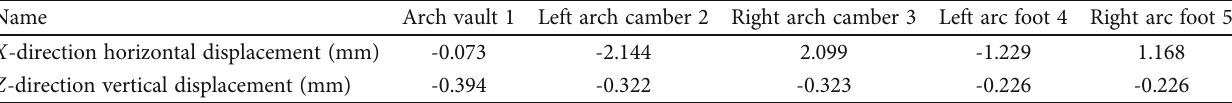
Table 3: Displacement values of the key points under self-weight.